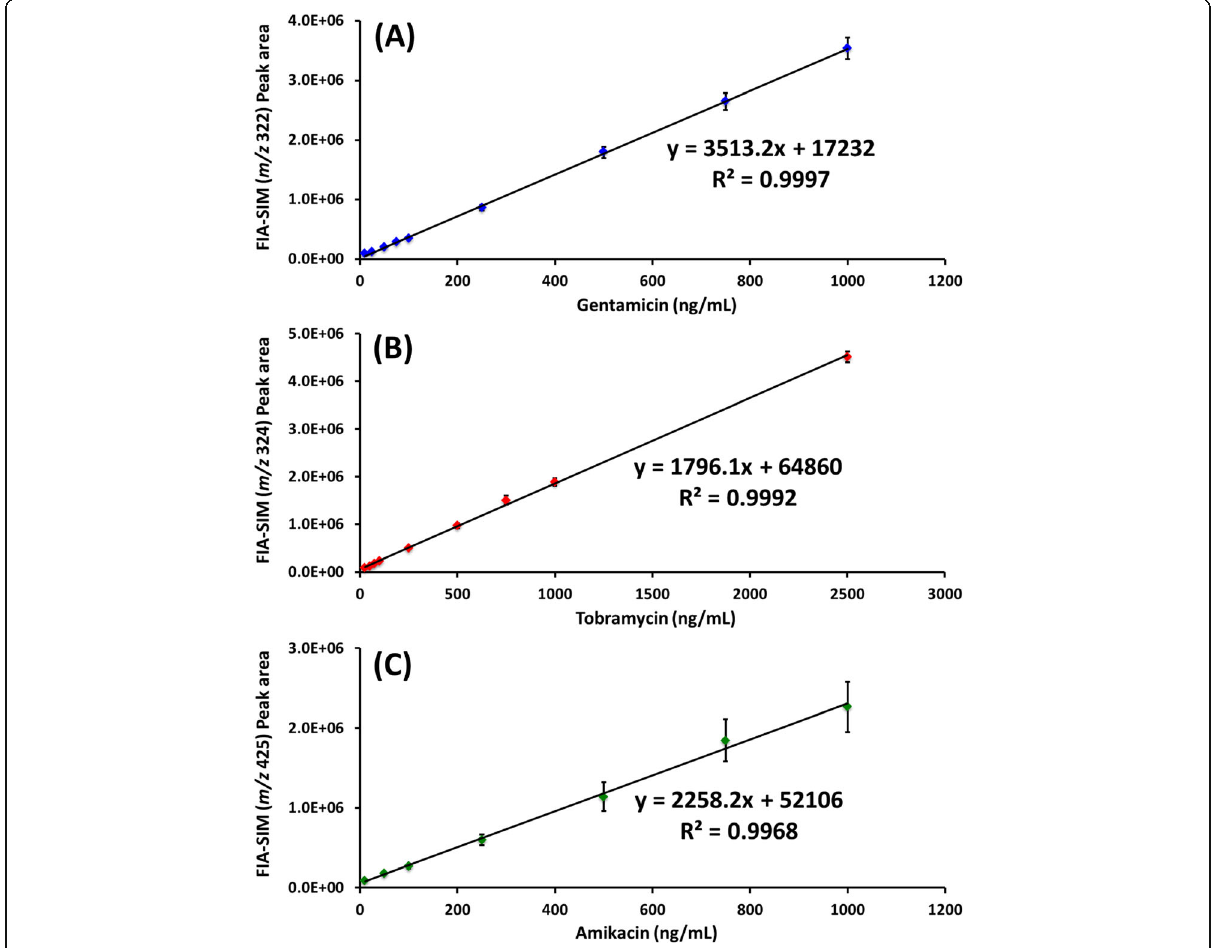
Fig. 5 Linear regression curves obtained for gentamicin ( a ), tobramycin ( b ), and amikacin ( c ) by the FIA-SIM method (error bars smaller than the width of the data-point bullets are not